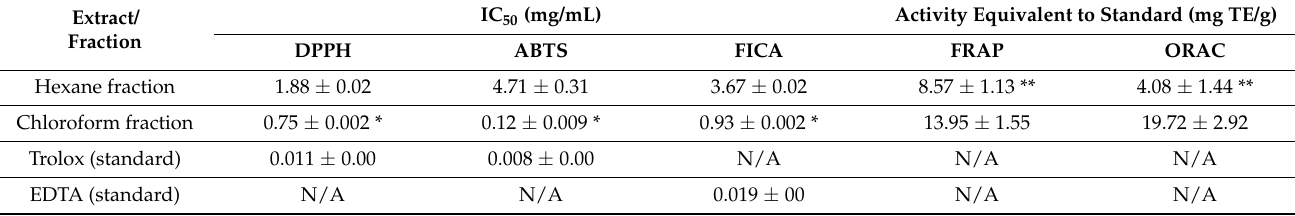
Results are expressed as mean ± SD; n = 4. p < 0.05 compared between two fractions. *: p < 0.05) of DPPH, ABTS, and FICA activity of the chloroform fraction compared to the hexane fraction. **: p < 0.05—significant high antioxidant activity exhibited by the hexane fraction, compared to the chloroform